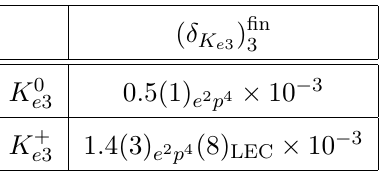
Table 2 . The IR-finite contribution from the three-point